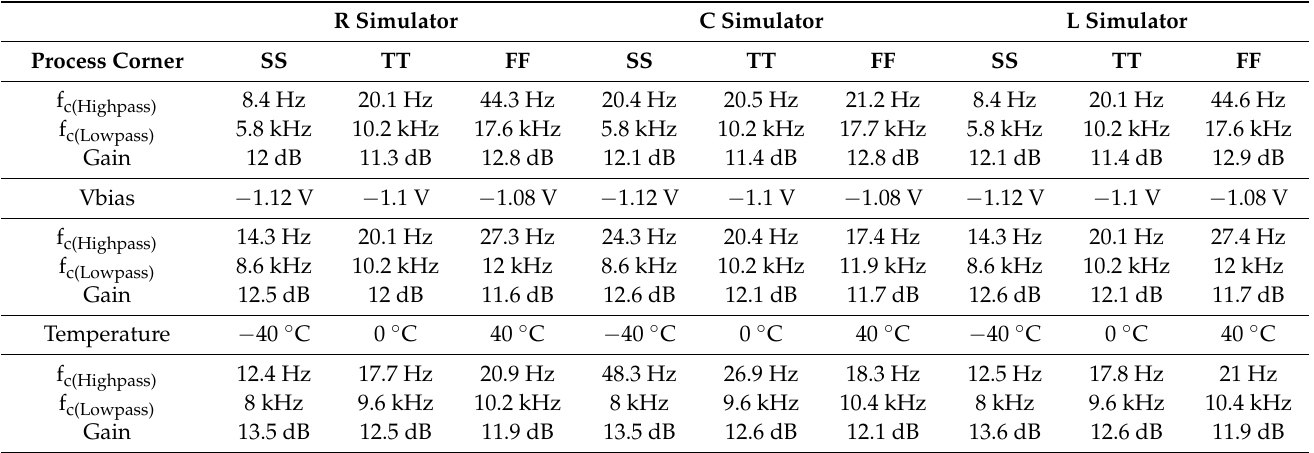
Table 9. PVT corner analysis for the cascaded filter